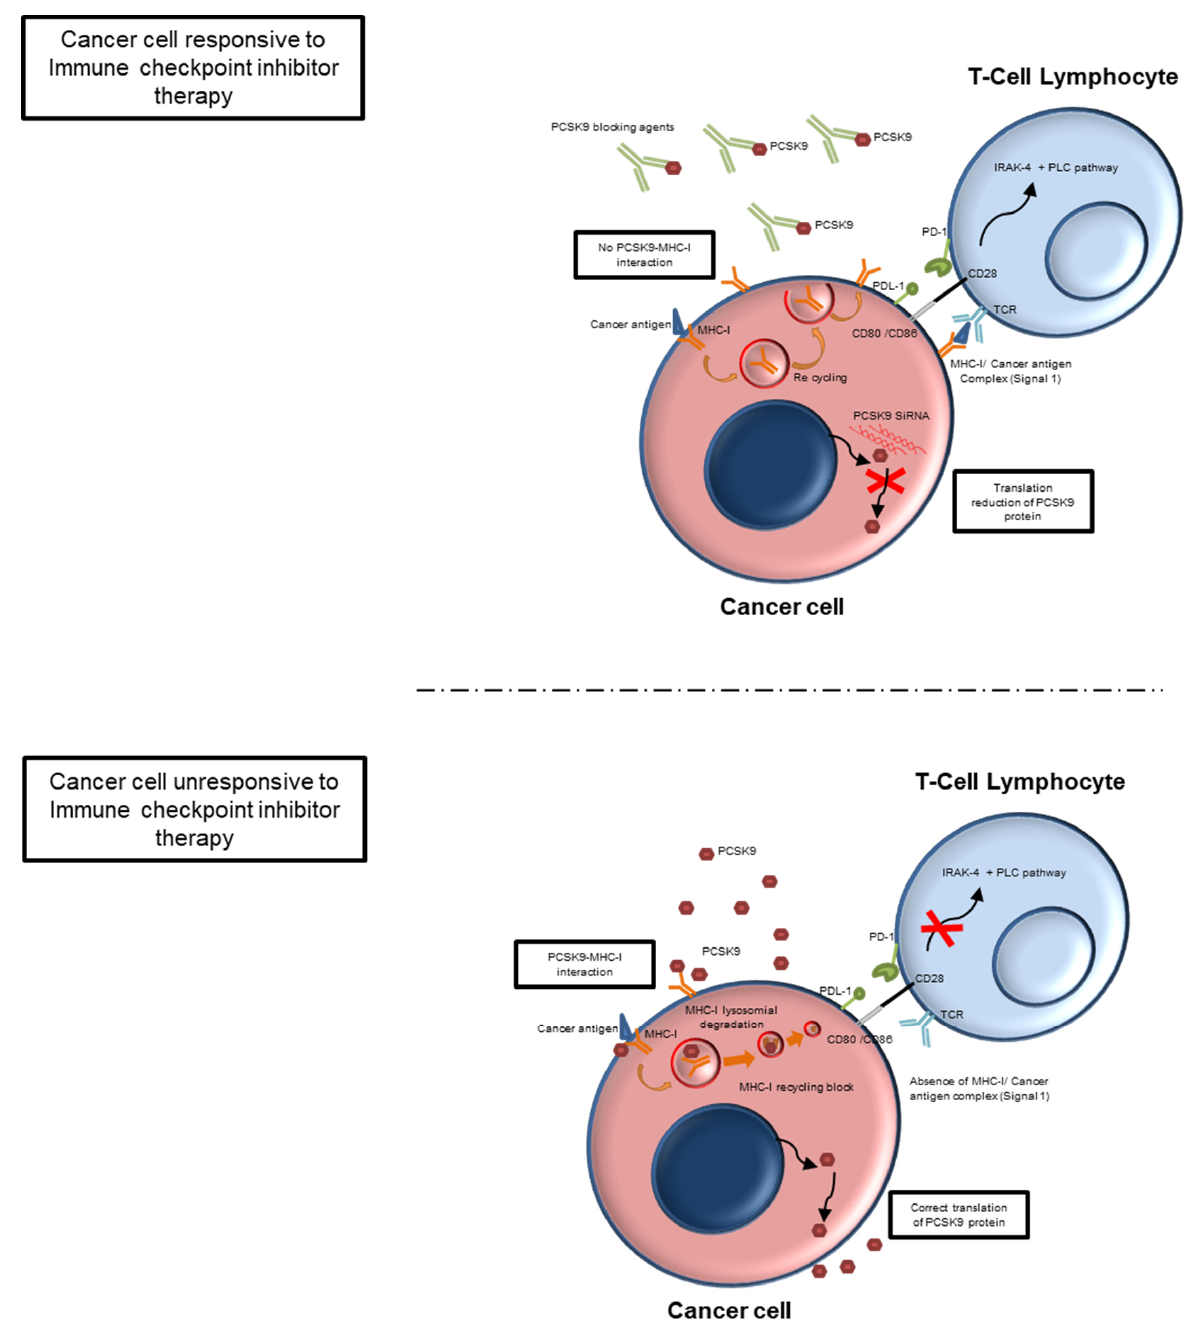
Figure 3. PCSK9 role in cancer immune-recognition. PCSK9 induces lysosomal degradation of MHC-I after binding to a cancer antigen, thus reducing cancer membrane MHC-I density, making the tumor cell immune-irresponsive (peripheral immune tolerance). When PCSK9 is blocked by monoclonal antibodies, MHC-I is recycled after binding to a cancer antigen, therefore allowing the recognition of the MHC-I-Antigen complex by the TCR (signal 1) which, thanks to the type 2 signal (CD28-CD8 binding), allows the activation, proliferation, and survival of the T lymphocyte and the consequent rupture of the peripheral immune